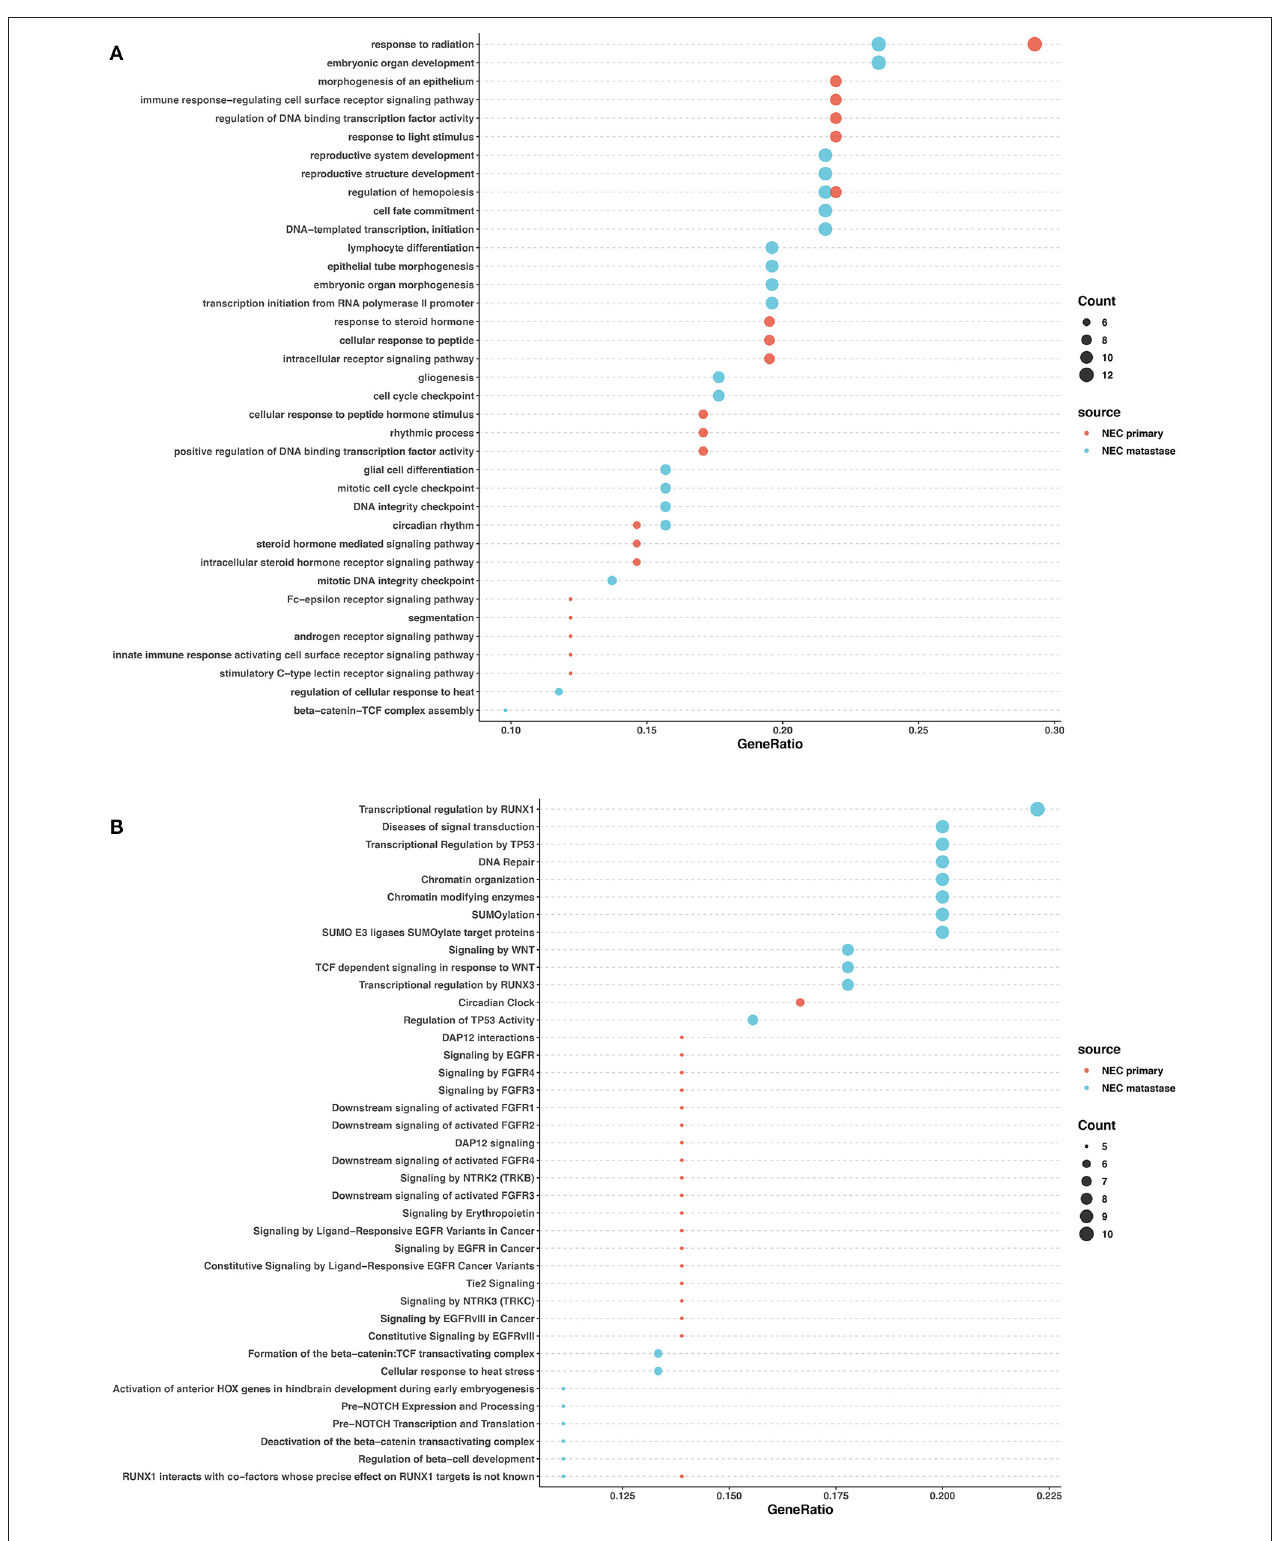
FIGURE 5 | GO and pathway enrichment analysis of mutated genes involved in NECs. GO enrichment analysis of biological processes in mutated genes in NECs (A) . Reactome pathway enrichment analysis in NEC (B) . Dot size corresponds to number of genes; gene ratio is defined as the percentage of genes in certain pathways compared with all genes in the